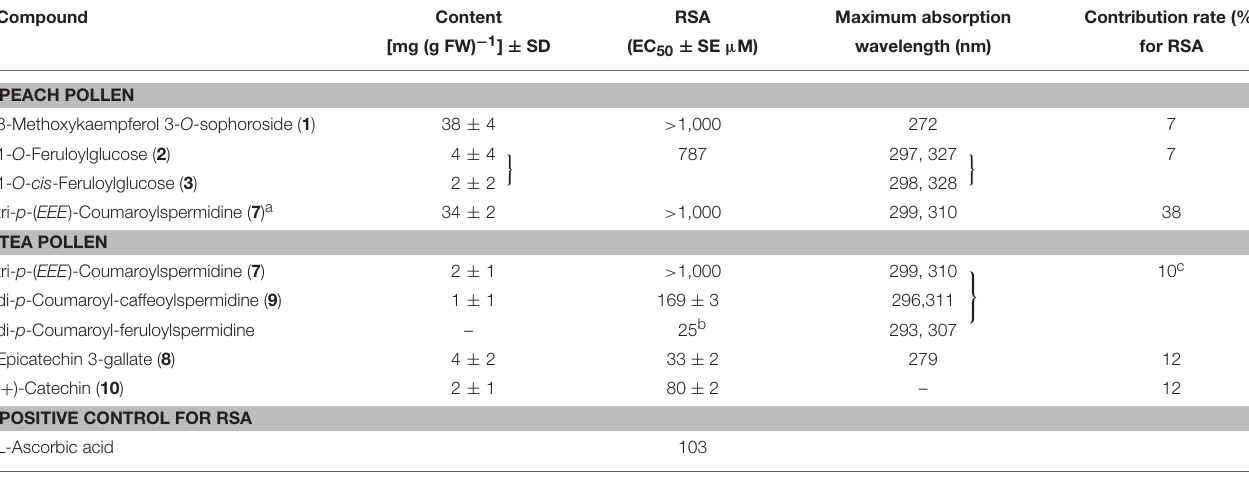
TABLE 1 | Contents, activities and maximum absorption wavelength of antioxidants in peach and tea pollens.